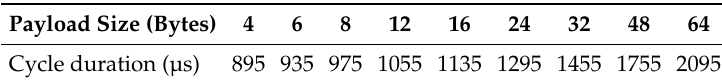
Table 5. Computation overhead and busload (synthetic